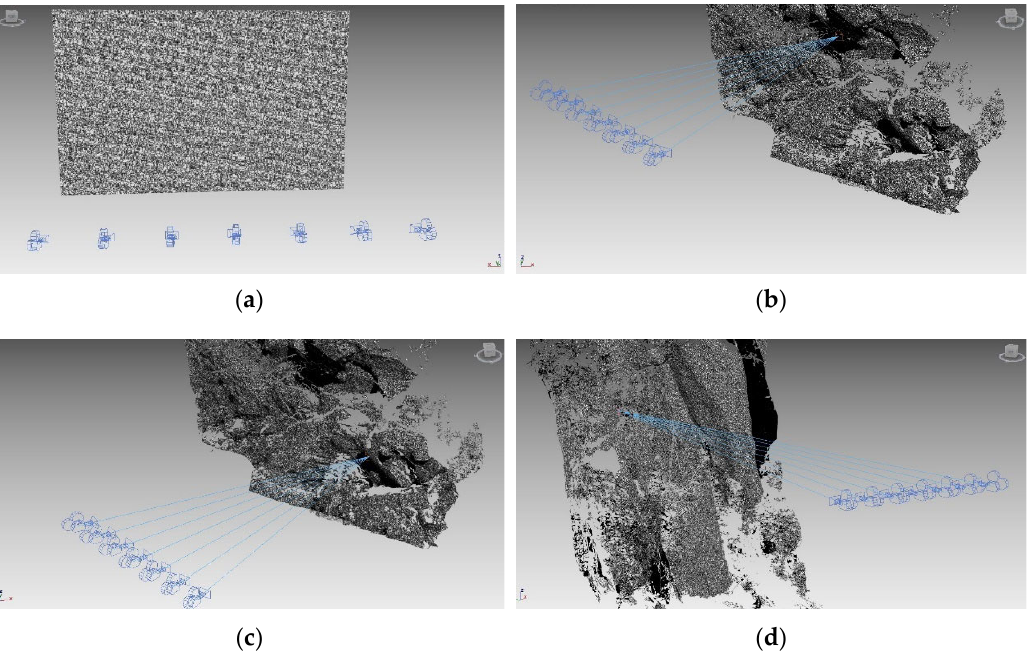
Figure 4. The four virtual sites considered in the study: ( a ) Site A1. ( b ) Site B1. ( c ) Site C1. ( d ) Site D1.